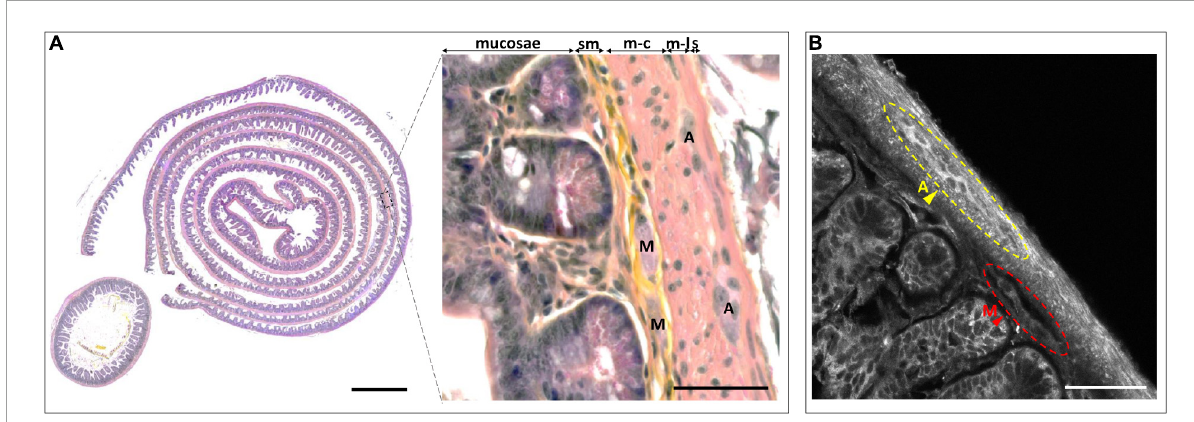
FIGURE1 Benchmark histological observation of the enteric nervous system (ENS). (A) Hematoxylin/erythrosine/saffron (HES) stained intestinal Swiss roll (left) and transversal slice (left-inset). Magnification of a part of the intestinal wall observed on the Swiss roll, highlighting the different layers and components of the ENS (right). sm, submucosa ; m-c, muscularis circular ; m-l, muscularis longitudinalis ; s, serosa ; A, Auerbach’s plexus ; M, Meissner’s plexus ; Scale-bars: 500 µ m (left), 50 µ m (right). (B) Autofluorescence (AF) imaging from an intestinal Swiss roll under 405-nm excitation. A, Auerbach’s plexus ; M, Meissner’s plexus ; Scale-bar: 50 µ